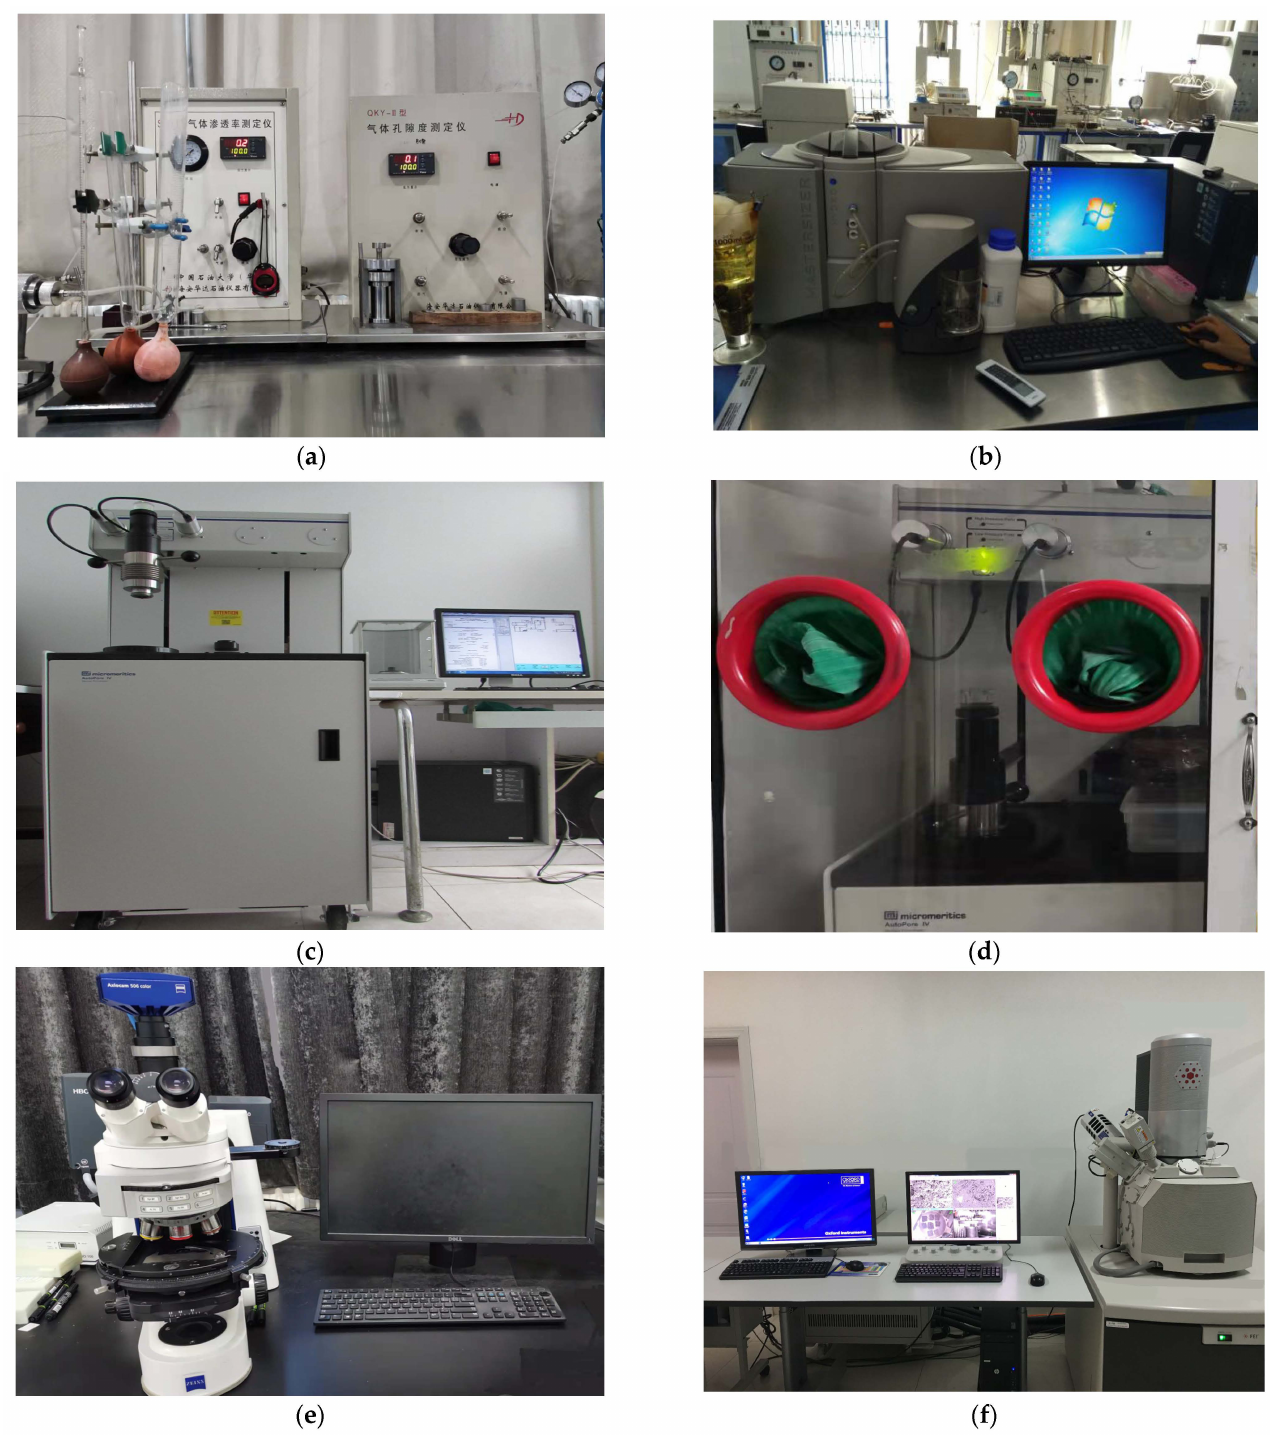
Figure A8. The experimental devices used in the present research. ( a ) STY-2 gas permeability and porosity meters. ( b ) Mastersizer 3000E laser grain size analyzer. ( c ) MAP 9500 mercury porosimeter (overall photo). ( d ) MAP 9500 mercury porosimeter (photo enlarged locally). ( e ) Zeiss Imaging-2M polarizing microscope. ( f ) Nova Nano 450 scanning electron